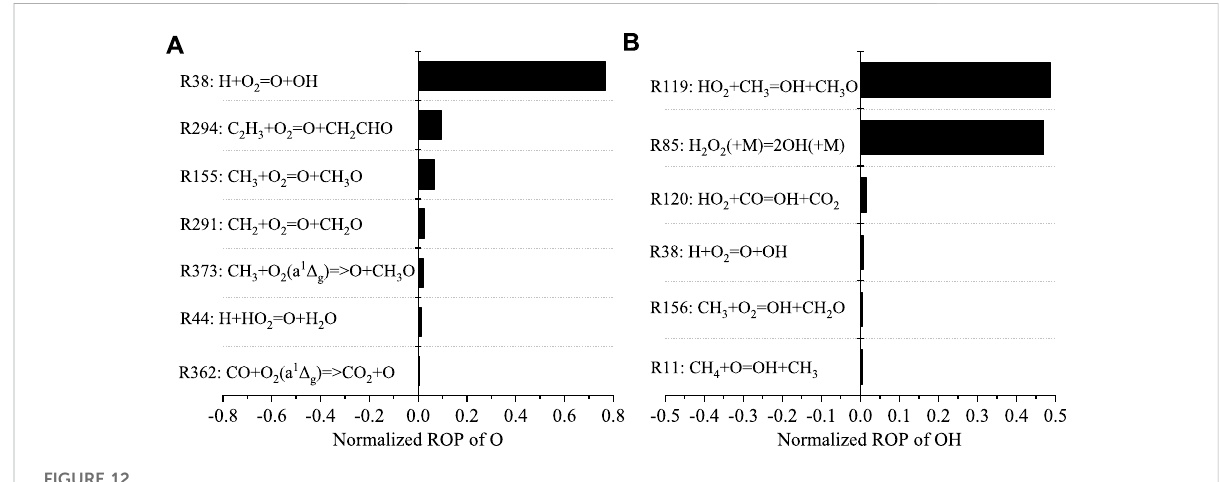
FIGURE 12 Normalized ROP of (A) O and (B) OH for case 2 at 357.5 CAD.